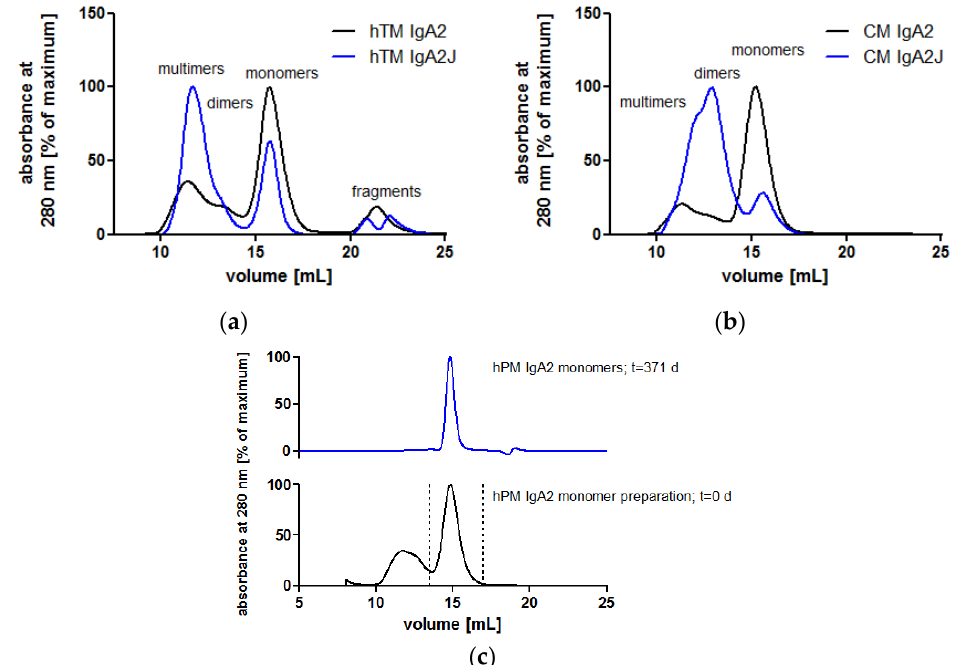
Figure 4. J chain co-expression promotes dimer and multimer formation of IgA antibodies, and monomers are stable during one year of storage. Comparison of hTM ( a ) and CM IgA2 ( b ) with and without J chain co-expression by size exclusion chromatography (SEC). Co-expression of the J chain resulted in a decrease of monomers and an increase in dimers and multimers. Monomer contents were 56% and 75% for hTM and CM IgA2 antibodies, respectively. Monomer contents were 27% and 16% for hTM and CM IgA2J, respectively. ( c ) hPM IgA2 monomers were generated, and after one year of storage (top, blue), no aggregation or fragmentation was observed. Fractions pooled for monomer generation by preparative SEC are indicated (vertical dotted line).